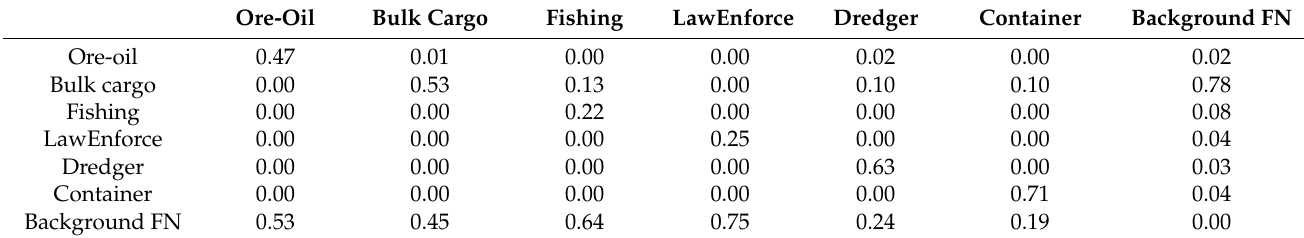
Table 8. The confusion matrix of proposed method in the six categories of